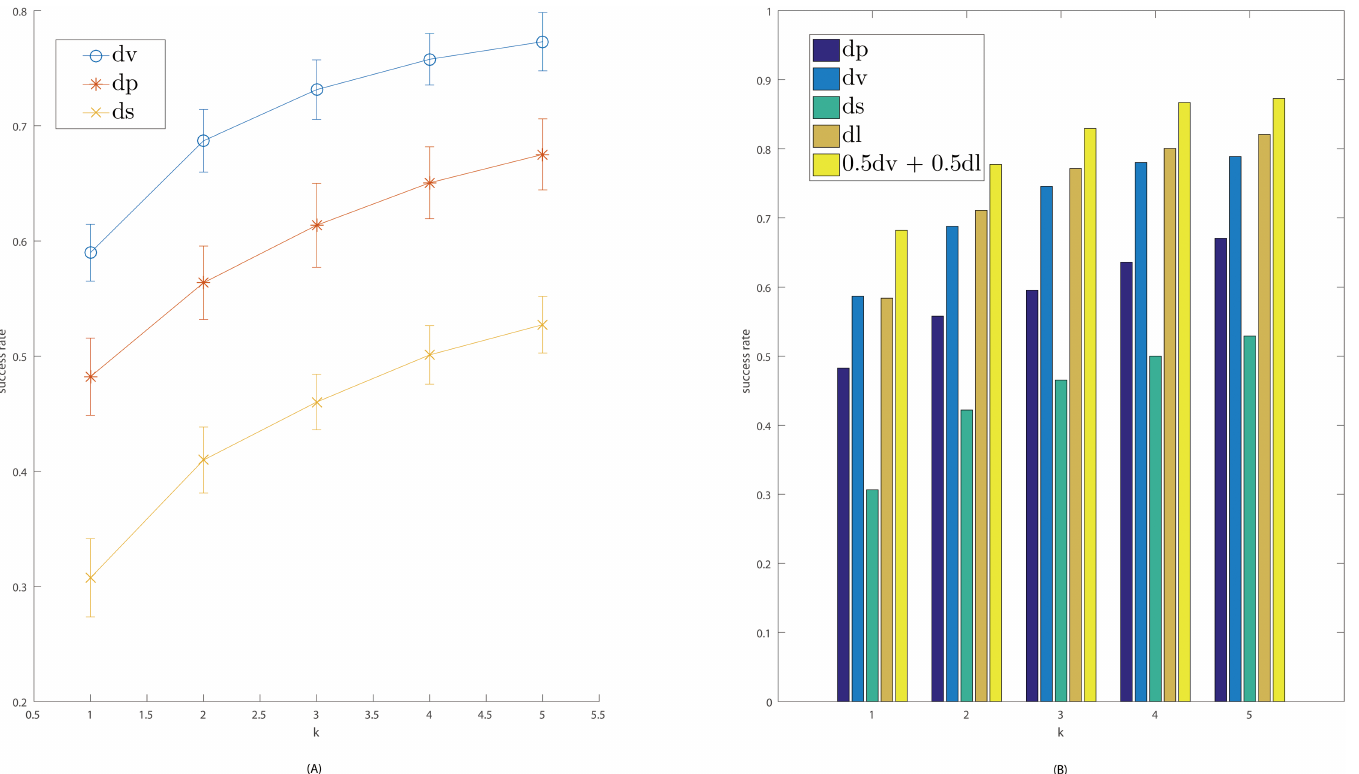
Fig 7. More results for Dataset1. In both figures, x -axis represents value of k , and y -axis is the success-rate. (A) shows the mean and standard deviation (vertical bar) of the success-rates for k -nearest neighborclassification. (B) Comparisonof success-rates basedon persistencediagram distance d P